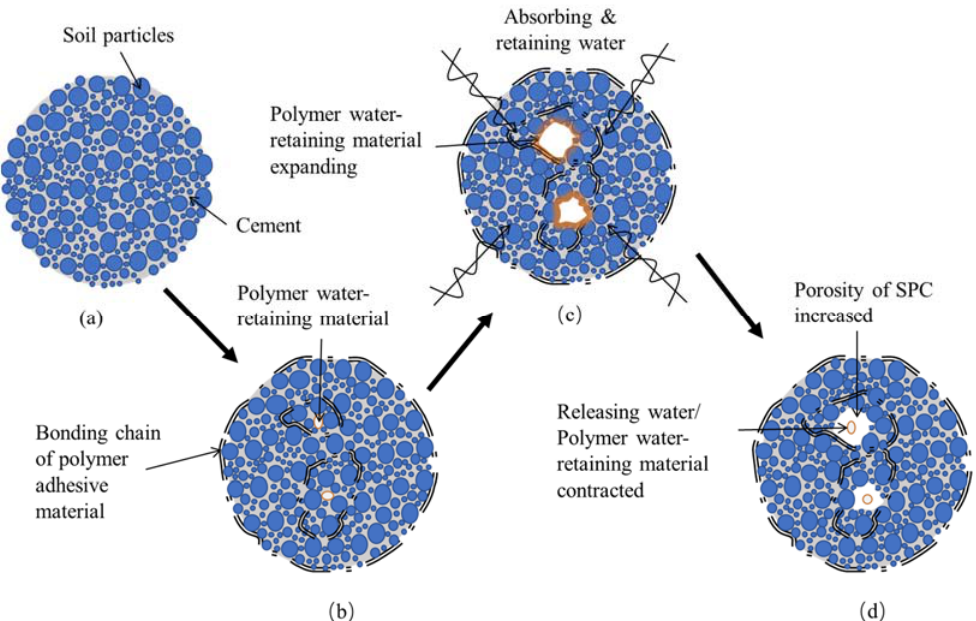
Figure 10. Illustration of improvement mechanism of polymer composite material on SPC: ( a ) the unimproved SPC; ( b ) the molecular chain of the polymer adhesive material improved the stability of SPC; ( c ) water-retaining material expands and exerts extrusion pressure on the surrounding soil; ( d ) the volume expansion and contraction of the polymer water-retaining material leads to an increase in the SPC pores.